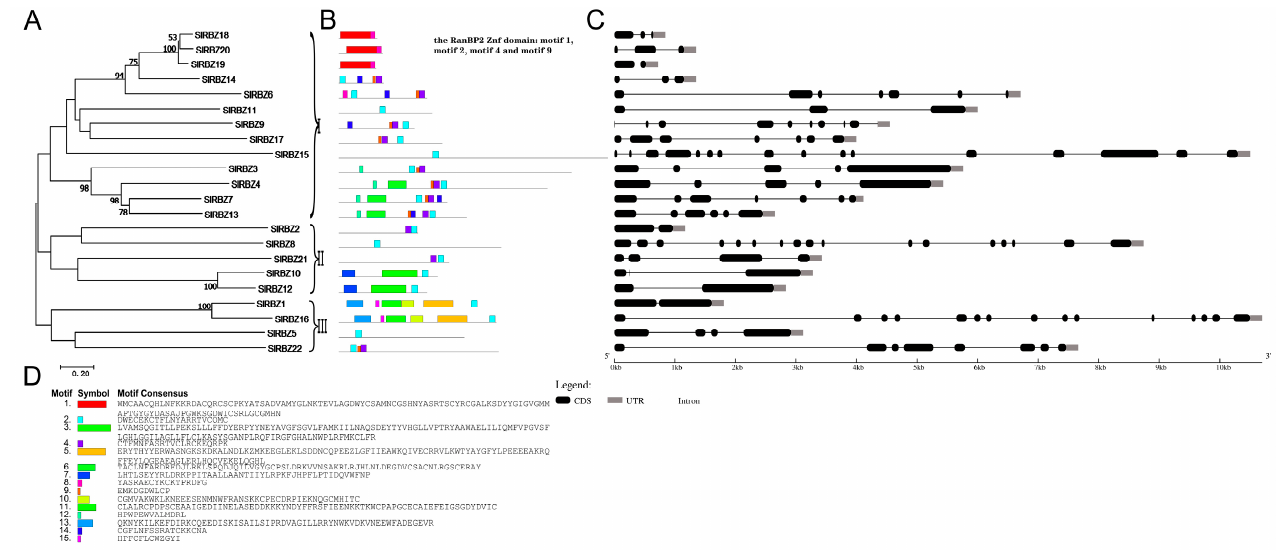
Figure 1. Phylogenetic tree ( A ), conserved motif distribution ( B ) and sequences ( D ), and gene structure ( C ) of the SlRBZ genes. Motif 1 or Motif 2, or a combination of Motifs 9 and 4, represent the typical RanBP2 Znf